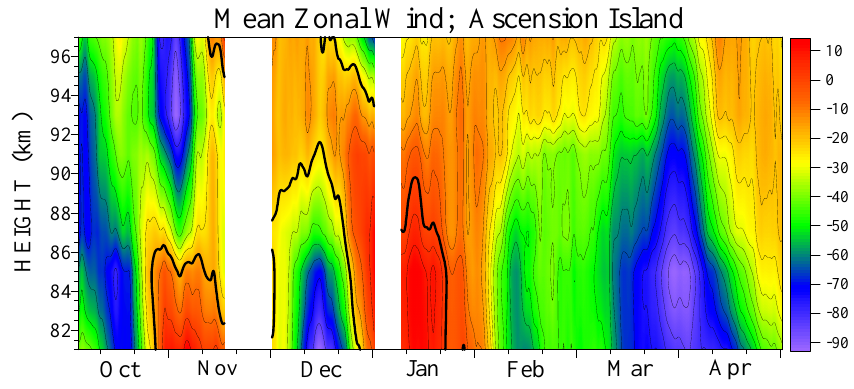
Fig. 1. Time-height cross section of the smoothed zonal wind (by 10-day run- ning means) observed over Ascension Island between October 2001 and April 2002. Solid line indicates zero veloc- ity. The white regions indicate missing